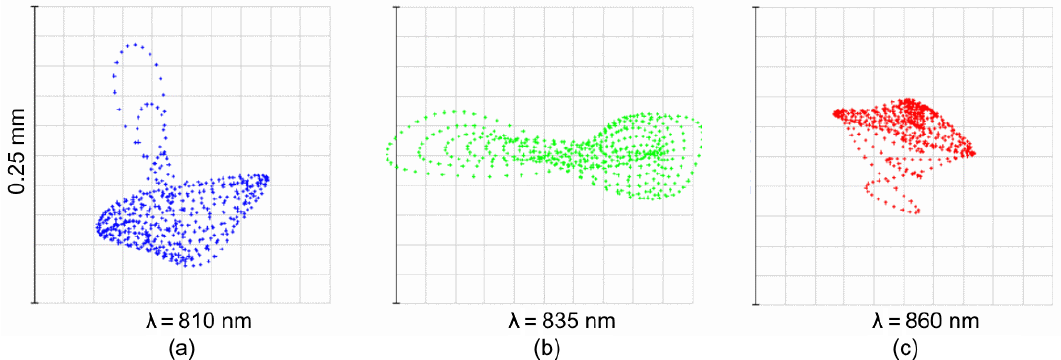
Figure 8. Spot diagrams of the high-dispersion spectrograph Design B.